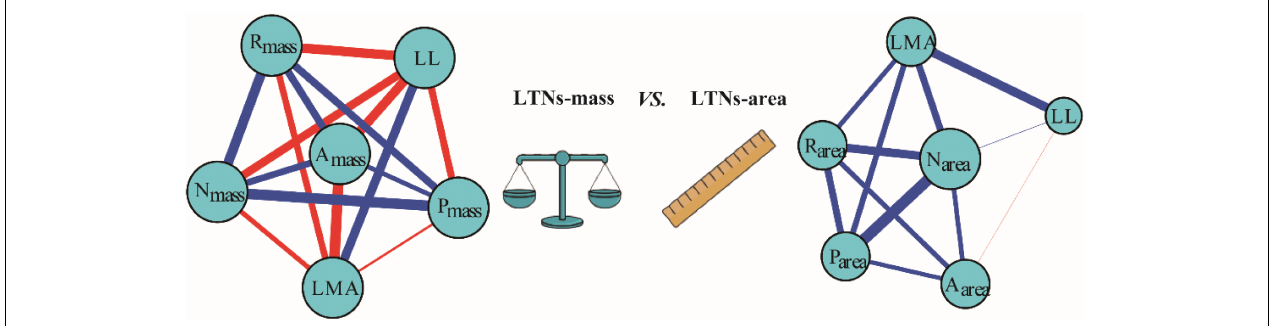
FIGURE 2 | Leaf traits networks (LTNs) for six leaf traits based on global data. Red and blue edges show negative and positive correlations, respectively. The correlation strength among traits is shown by line thickness. The node size is shown as degree. Data on leaf traits were derived from the report by Wright et al. (2004).